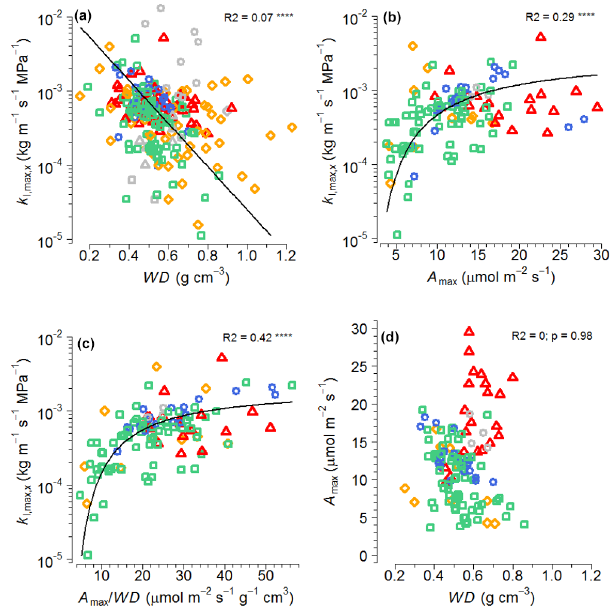
Figure 5. (a–c) Tropical synthesis of maximum xylem conductiv- ity per unit leaf area ( k l,max ) in relation to wood density (WD) and light-saturated photosynthesis rate ( A max ) . (d) No significant corre- lation between A max and WD exists in this dataset, justifying their use as independent simultaneous predictors of k l,max . Symbols as in Figs. 2–3. See Supplement Fig. S2.2 for a version of this figure in terms of k s,max . Asterisk codes for significance are the same as in Fig.